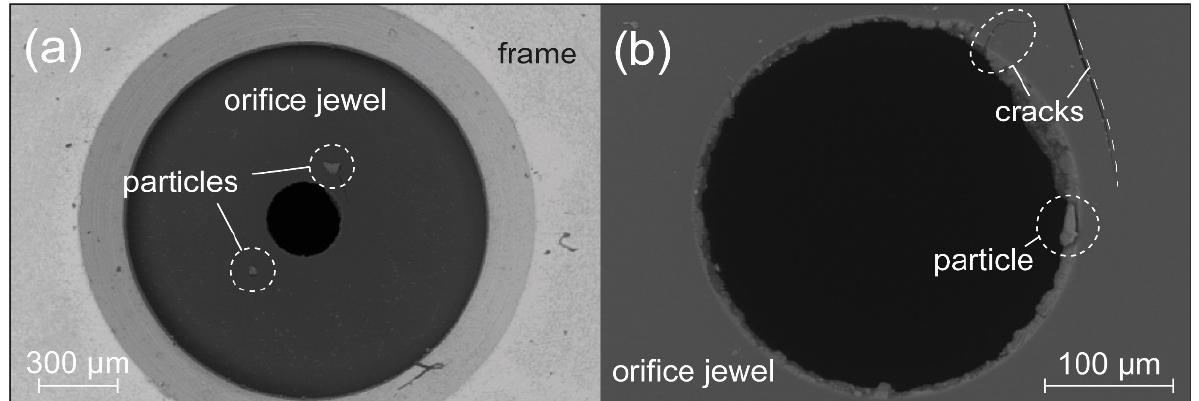
Figure 7. SEM images of a type 91 sapphire orifice that are expected to show premature failure: ( a ) overview showing two distinct particles on the orifice jewel after 45 min of operation at an operating pressure of 300 MPa and 19 switching operations, and ( b ) high magnification detail of the orifice bore demonstrating the presence of a particle at the orifice edge as well as cracks spreading into the orifice jewel.